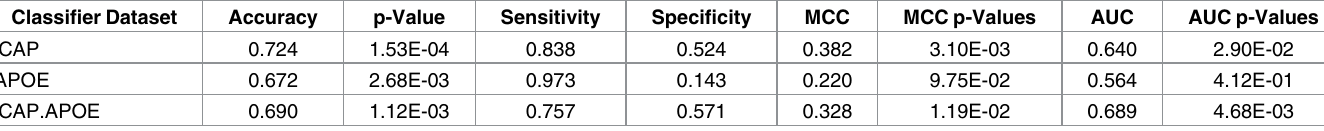
N = 58 samples, 38 MCI and pre-MCI Disease samples and 20 Normal Samples. No multiple testing correction was performed. MCC, Matthews correlation coefficient; AUC, area under the ROC